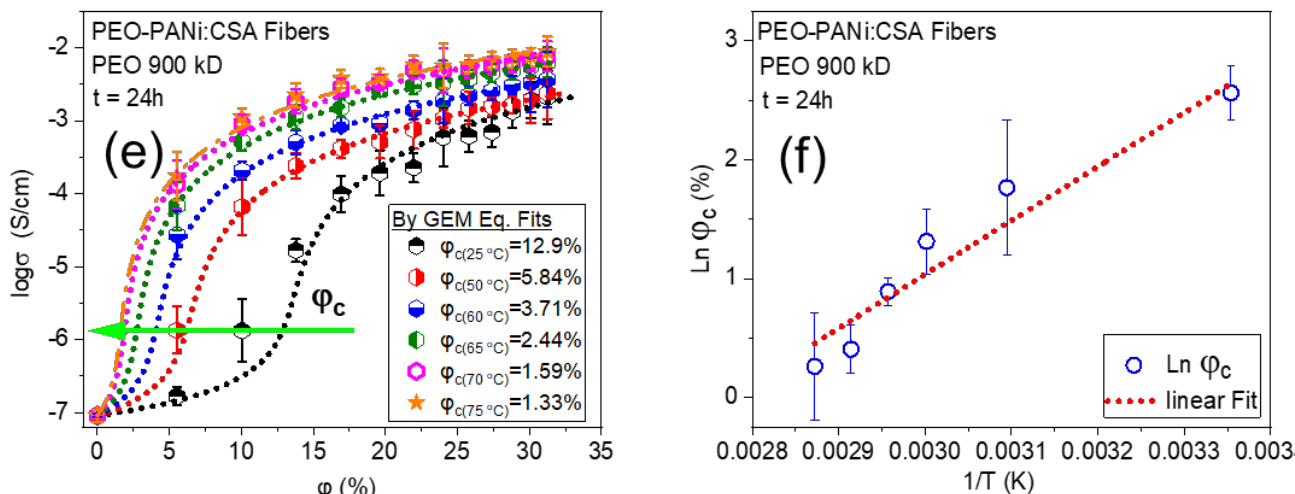
Figure 6. Logarithm of conductivity ( log σ ) against percentage volume fraction ( ϕ % ) of PANi for PEO-PANi:CSA fibers. Panel ( a ) shows the trend in ϕ c for PEO-PANi:CSA fibers for different molar masses of PEO (300 kD, 600 kD, 900 kD, 2000 kD, and 4000 kD). Panel ( b ) shows the power law correlation between molar mass ( M ) and fiber diameter ( d f ) with a coefficient g = 0.13 and exponent h = 1.27. The inset graph shows the linear fit of Log d f − Log M. Panel ( c) shows a power law correlation between fiber diameter ( d f ) and percolation threshold ( ϕ c ) with a coefficient m = 1.06 and exponent n = 0.35. Panel ( d ) shows a power law dependence of percolation threshold ϕ c on molar mass M for PEO-PANi:CSA fibers with coefficient a = 0.62 and exponent b = 0.43. Panel ( e ) shows the temperature T dependence on percolation threshold ϕ c of PEO(900 kD)-PANi:CSA fibers. The annealing is conducted at 50, 60, 65, 70, and 75 ◦ C for 24 h. The linear relation between natural logarithm of percolation threshold ( Ln ϕ c %) and inverse of the annealing temperature (1/T in Kelvin) indicates an Arrhenius activation process ( f